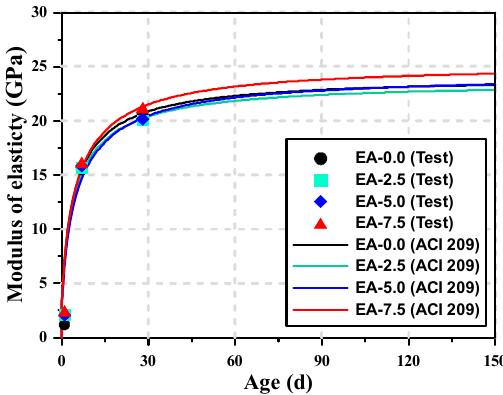
Figure 2. Comparison of modulus of elasticity between the test results and the results of the ACI 209 model. Table 4. Material constants of the modulus of elasticity of AAM mortar.